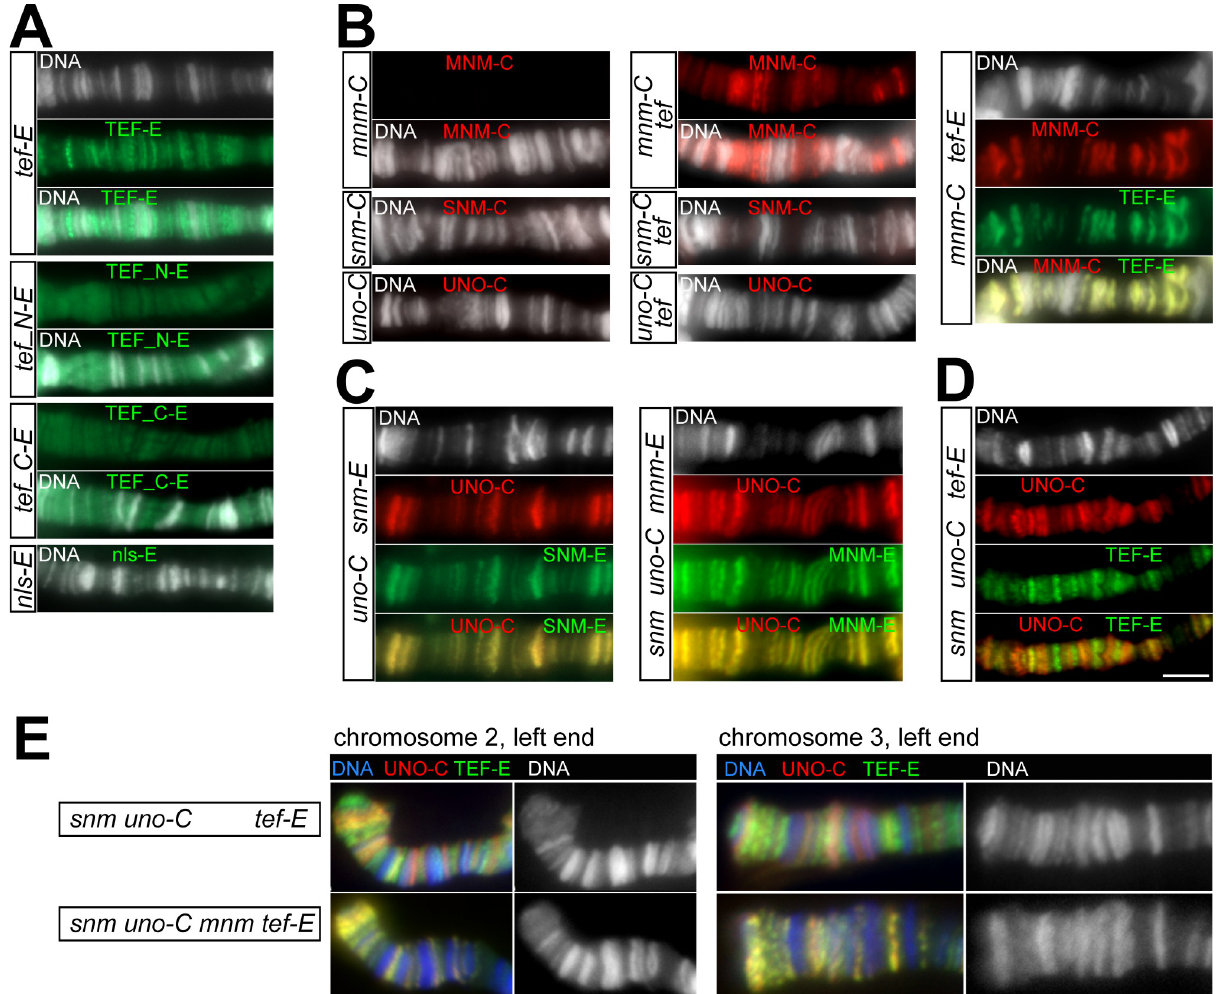
Fig 4. Binding of alternative homolog conjunction proteins to polytene chromosomes. ( A-E ) Squash preparations of larval salivary glands expressing various fluorescently tagged AHC proteins from UASt transgenes driven by Sgs3-GAL4 for assessment of their binding to polytene chromosomes that were labeled with a DNA stain (DNA). ( A ) TEF binds efficiently to polytene chromosomes. While full-length TEF-EGFP (TEF-E) associates with specific sub-regions within interbands, the N-terminal (TEF_N-E) and C-terminal (TEF_C-E) halves of TEF, which include one and two zinc fingers, respectively, display only weak chromosome binding. No chromosome binding was observed for nls-EGFP (nls-E). ( B ) TEF recruits MNM to polytene chromosomes. MNM-mCherry (MNM-C), SNM-mCherry (SNM-C) and UNO-mCherry (UNO-C) do not associate with polytene chromosomes (left panel). However, after co-expression of TEF, MNM-C is recruited to polytene chromosomes, in contrast to SNM-C and UNO-C (middle panel). TEF-E and MNM-C are perfectly co-localized after co-expression (right panel). ( C ) UNO and SNM bind together to polytene chromosomes and can also recruit MNM. UNO-mCherry (UNO-C) and SNM-EGFP (SNM-E) are perfectly co-localized on polytene chromosomes after co-expression (left panel). MNM-EGFP (MNM-E) associates with polytene chromosomes when co-expressed with untagged SNM (SNM) and UNO-C, with a chromosomal localization that is identical to that of UNO-C (right panel). ( D ) TEF and SNM-UNO bind to distinct sub-regions on polytene chromosomes. TEF-E signals on polytene chromosomes are not co-localized with UNO-C signals after co-expression along with untagged SNM. ( E ) Co-localization of all four AHC proteins (SNM, UNO, MNM and TEF) on polytene chromosomes. UNO-C and TEF-E have a distinct banding pattern after co-expression with untagged SNM (as also shown in panel D) and an essentially identical banding pattern after co-expression with both untagged SNM and untagged MNM, indicating that MNM recruits, on the one hand, SNM-UNO-C to TEF-E binding sites and, on the other hand, TEF-E to SNM-UNO-C binding sites. Scale bars = 5 μ